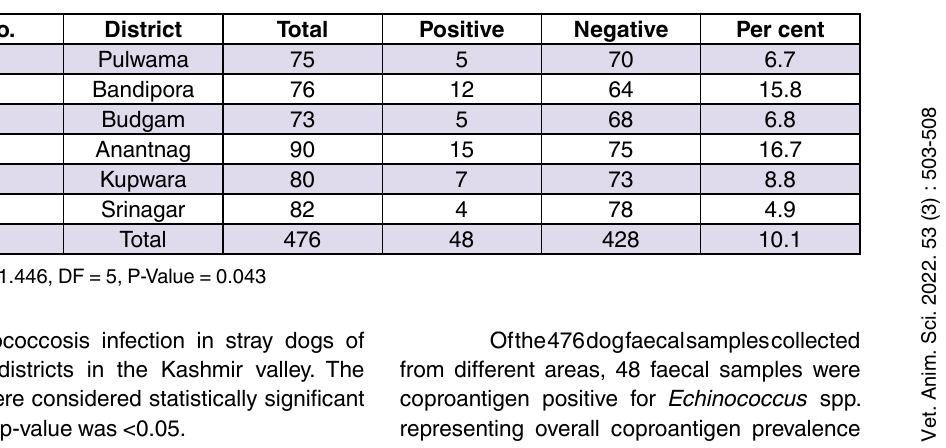
Fig. 2 . Prevalence of Echinococcosis infection in stray dogs of different districts of Kashmir table1. Prevalence of echinococcosis infection in stray dogs of different districts of the Kashmir valley